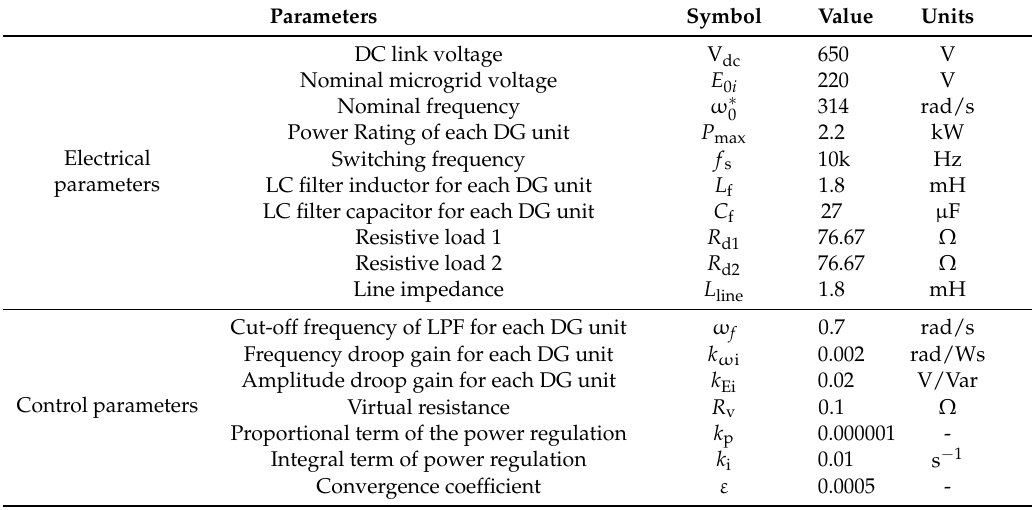
Table 2. Parameters of the system.